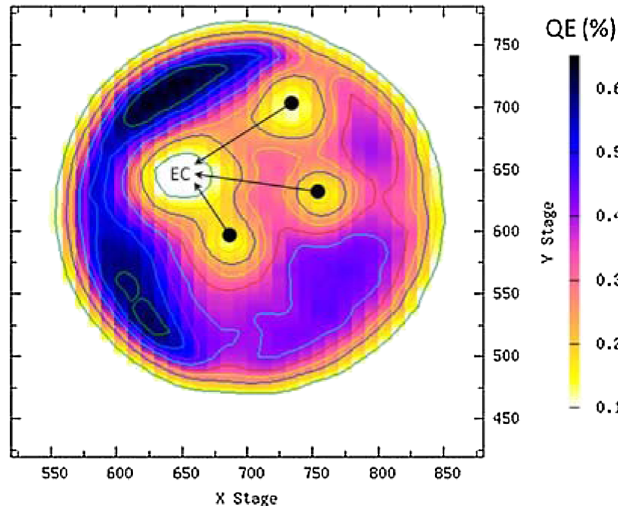
FIG. 1. QE measured across the surface of a strained super- lattice GaAs photocathode used at CEBAF that has been dam- aged by ions. The electron beam was extracted from three different radial locations. Note QE ‘‘trenches’’ that terminate at a common ‘‘electrostatic center